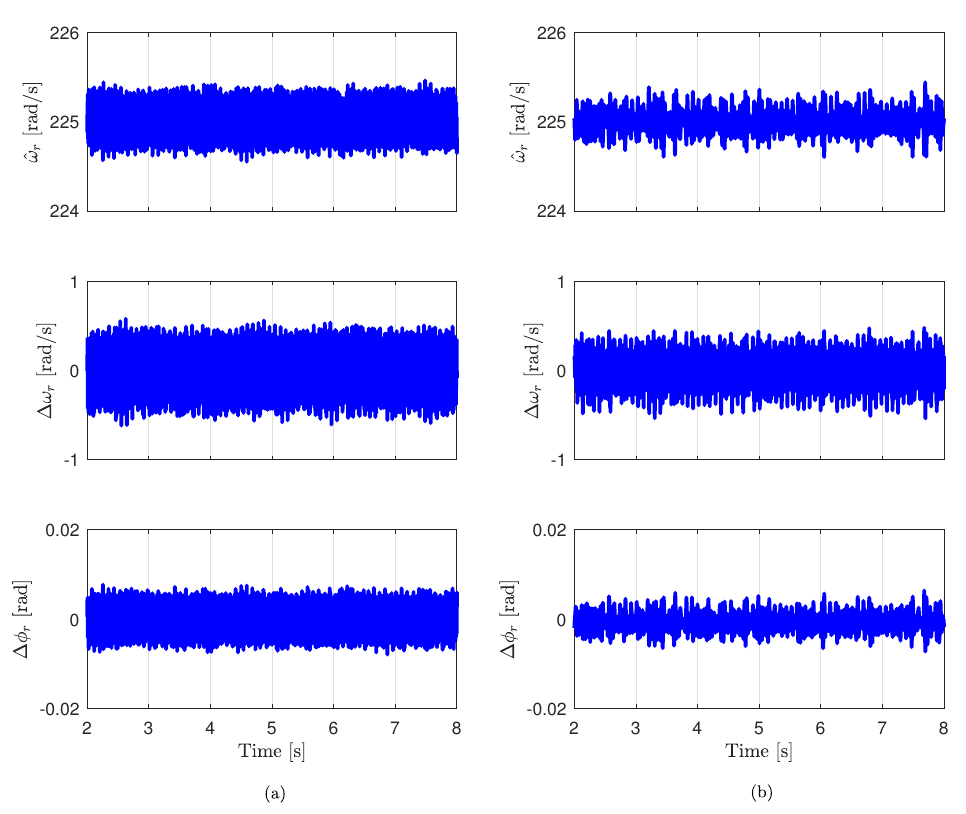
Figure 8. Experimental response at steady-state: ( a ) MRAS-FS estimator, and ( b ) conventional